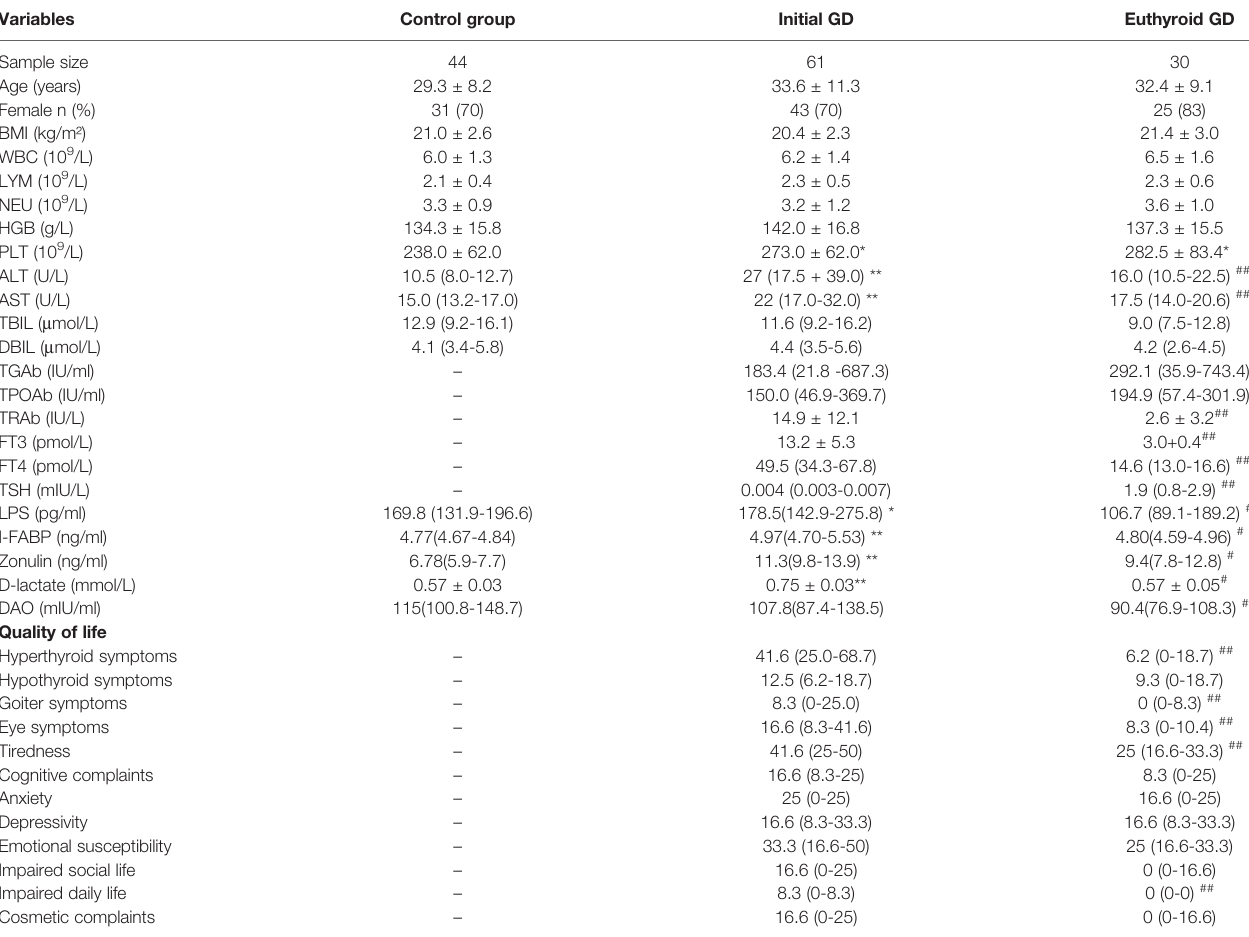
TABLE 1 | Demographic and clinical characteristics of patients with GD and control participants.